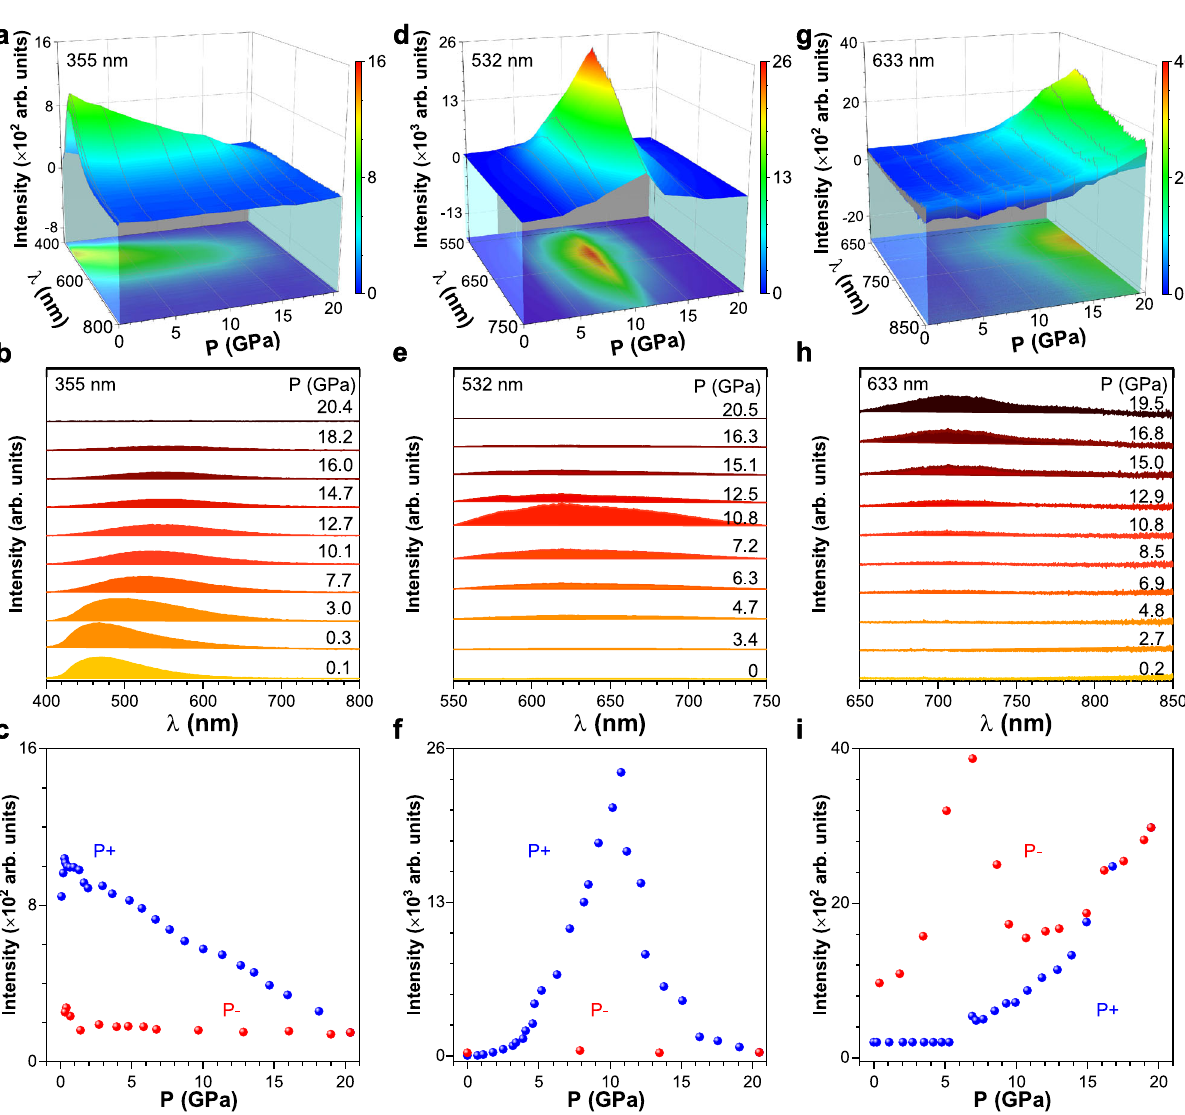
pressureduring compressionand decompressionprocesses underlaser excitation at ( c ) 355nm, ( f ) 532nm, and ( i ) 633nm. The color in ( a , d , g ) indicates the mag- nitude of fl uorescence intensity. P+ and P- in ( c , f , i ) indicate the fl uorescence during the compression and decompression,